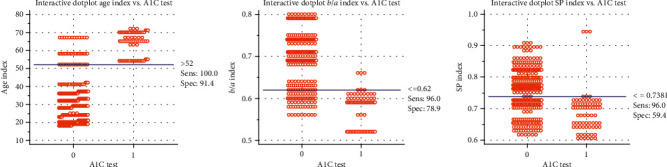
The interactive dot plot diagram for each independent variable, where 0 represents nondiabetic and 1 represents diabetic.